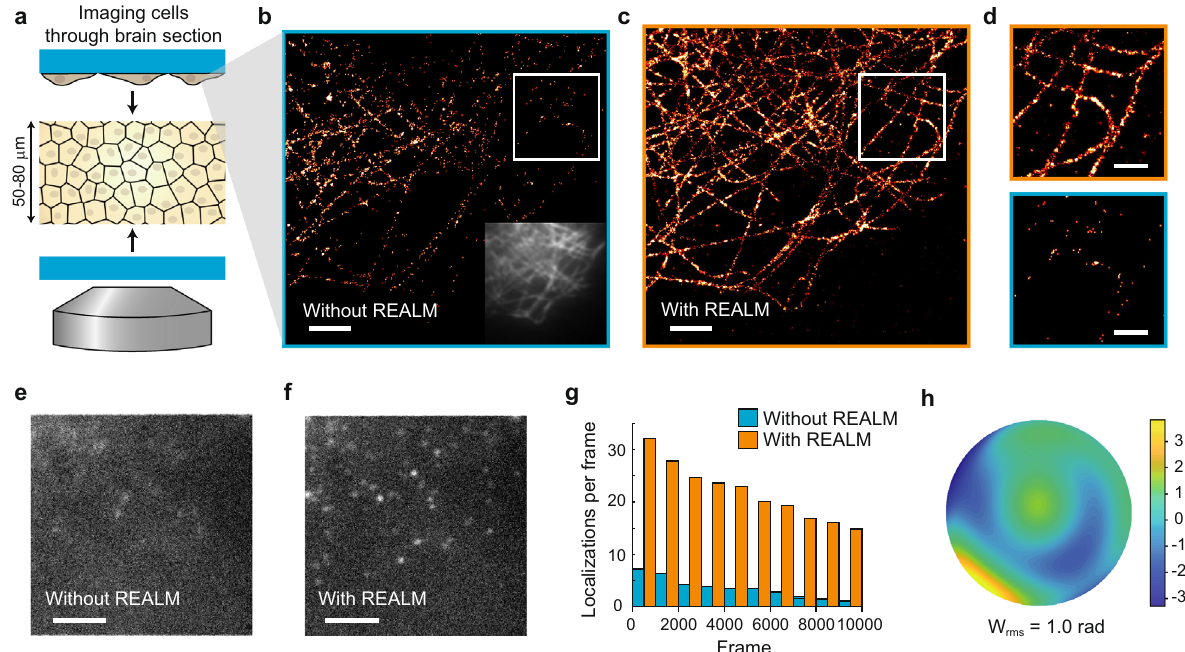
Fig. 2 Improved single-molecule imaging through brain sections using REALM. a Illustration of the sample. A 50- μ m brain slice is mounted in between two cover glasses, on one of which COS − 7 cells were grown. These cells were stained for microtubules ( α Tub) and imaged through the brain section, to mimic deep-tissue imaging. b , c SMLM reconstruction of microtubules in COS − 7 cells through a 50- μ m-thick brain section with 5000 frames without AO sample correction (without REALM, b ) and with sample-based correction (with REALM, c ). Insert in panel b shows the wide fi eld image prior to correction. FRC resolution is 196 nm and 127 for b and c respectively. Scale bars indicates 2 μ m. d zoom of b and c indicated by white square. Scale bars indicates 1 μ m. e , f Representative single acquisitions corresponding to the reconstruction of b and c respectively. Scale bars indicate 4 μ m. g Number of localizations in the acquisition series during which the DM alternated between the system-corrected state (without REALM) and sample-corrected state (with REALM) every 500 frames. h Estimated wave-front distortion as estimated using REALM, of which 0.55 rad was used as initial guess for primary spherical aberration. Repeated n = 10 times in three distinct samples. Source data are available as a source data fi